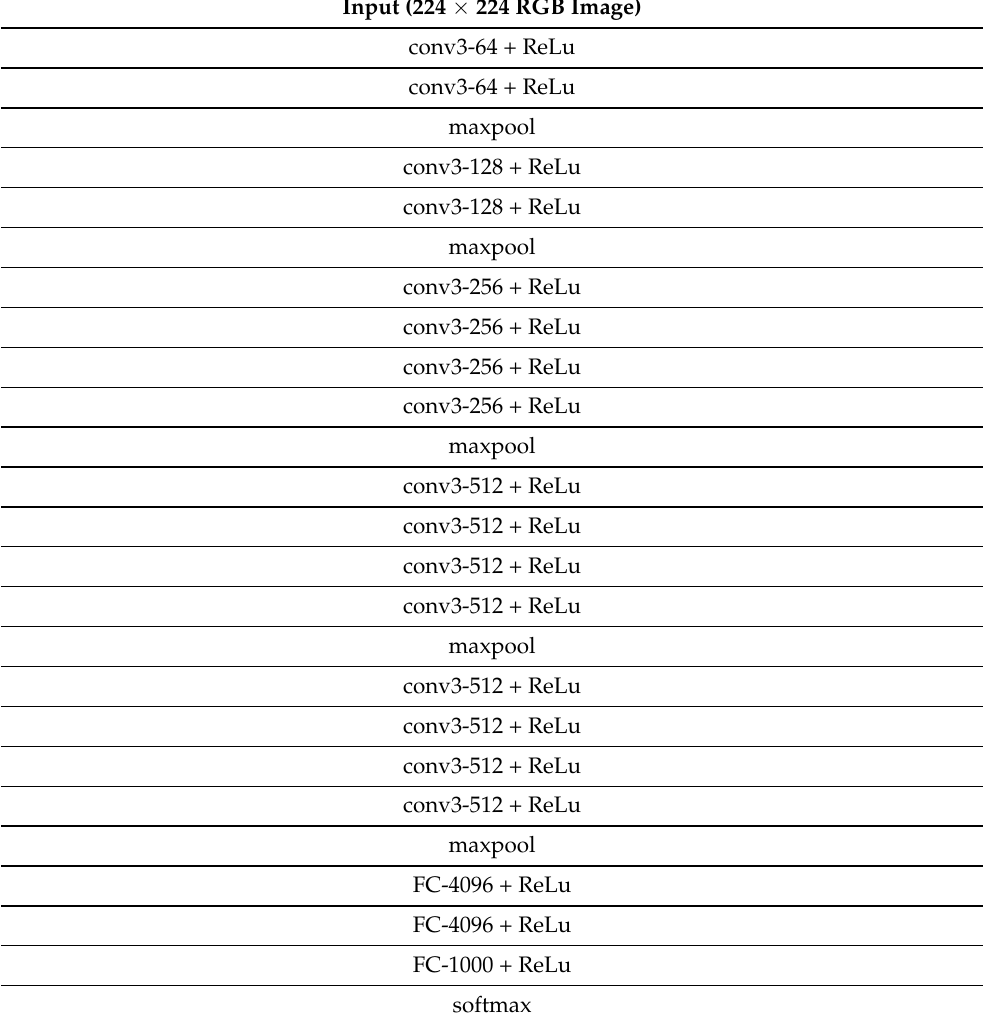
Table 1. Configuration of the VGG-19